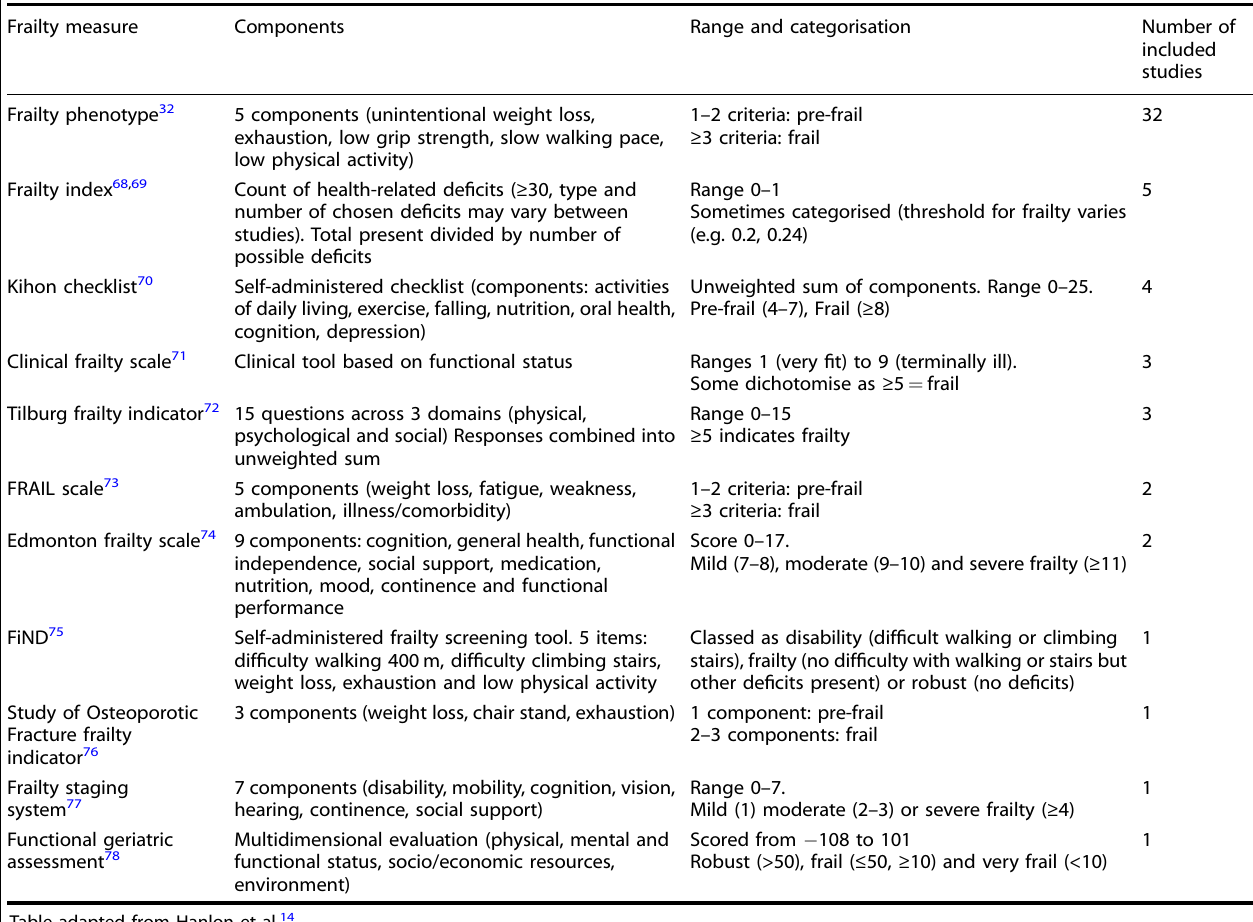
Table 2. Frailty measures used in the included studies.